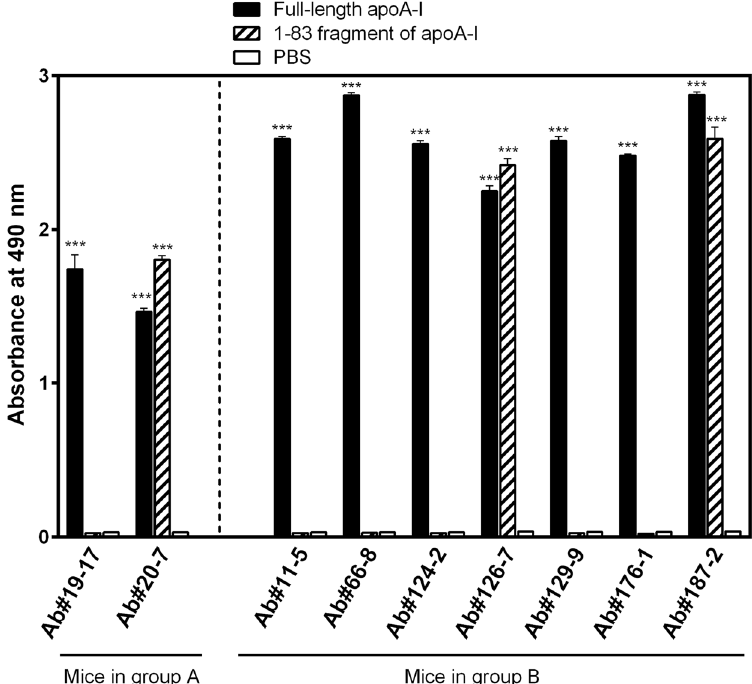
Figure 1. Reactivity of the present monoclonal antibodies to full-length and the N-terminal 1–83 fragment of apoA-I. Biotinylated full-length apoA-I or its N-terminal 1–83 fragment (0.3 μ M) in G-PBS, or PBS (for examining the background value) was added to 96-well microplates coated with streptavidin, and then incubated for 30 min at 37 °C. After washing the wells with T-PBS, hybridoma supernatants, 500-fold diluted with G-PBS, were added to the wells (100 μ l/well) and incubated at 37 °C for 30 min. After washing, POD- conjugated anti-mouse IgG antibody diluted at 1:5000 in G-PBS (100 μ l/well) was added and incubated for 30 min at 37 °C. The wells were washed and bound POD activity was determined colorimetrically (see Materials and Methods). *** P < 0.001 versus